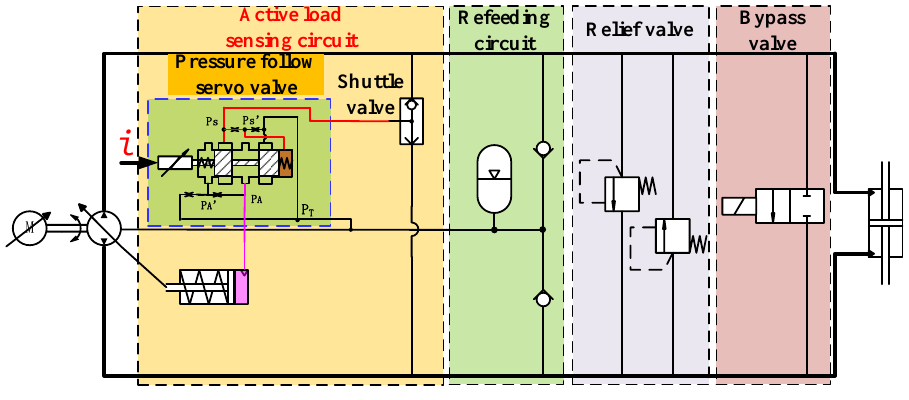
Figure 4. ALS-EHA schematic.